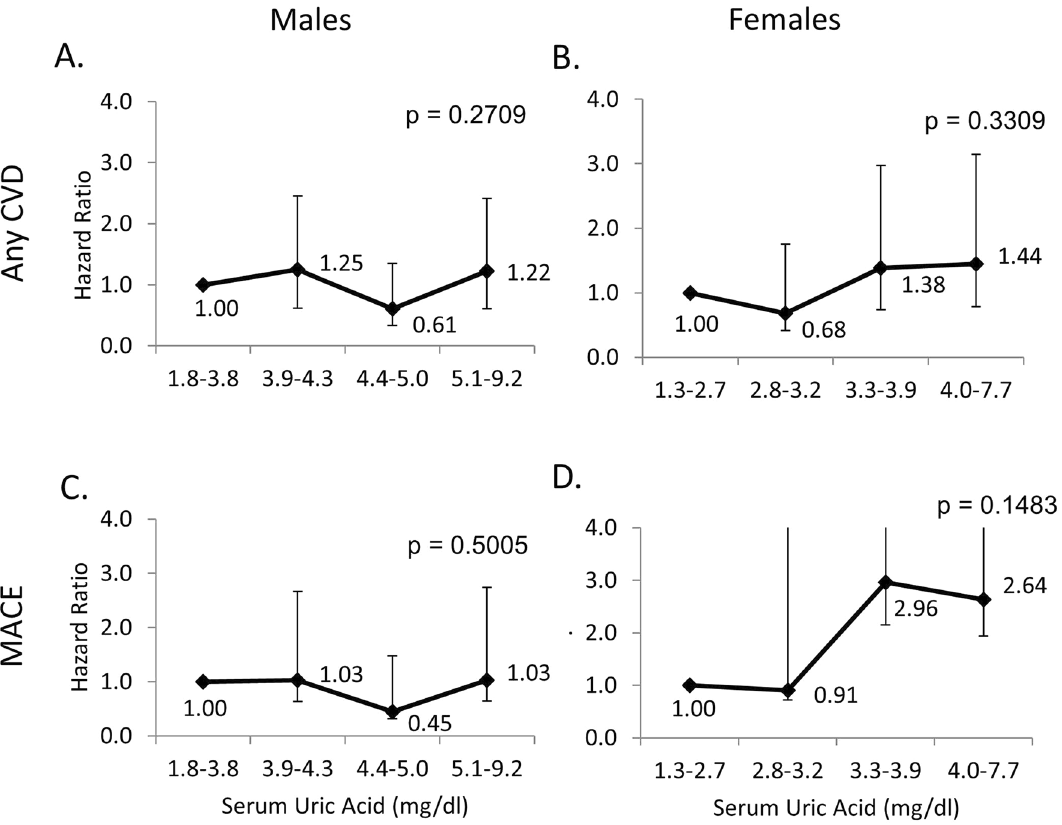
Figure 2. Hazard ratios for risk of ‘any CVD’ and MACE in men and women with type 1 diabetes, according to serum urate quartiles (relative to the lowest quartile). Hazard ratios for ‘any CVD’ are shown in ( A ) for men and ( B ) for women; those for MACE are shown in ( C ) for men and ( D ) for